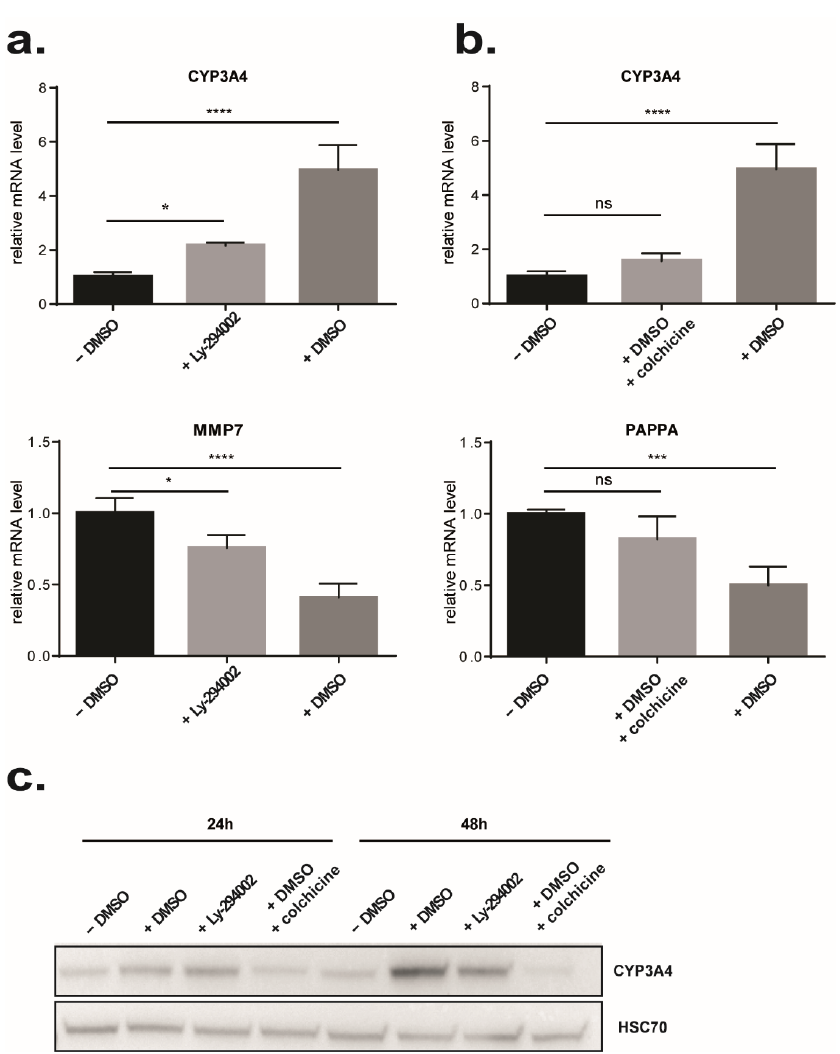
Figure 5. Comparison of DMSO effects with LY294002 and colchicine effects. At day 15 of differen- tiation HepaRG cells were treated for 24 h with 2% DMSO as positive control or with 10 µM LY294002, or 2% DMSO + 10 µM colchicine or let in classical medium without DMSO (negative control). ( a ) Effect of LY294002 treatment on CYP3A4 and MMP7 expressions was confirmed by real-time RT-PCR. (n = 4). ( b ) Effect of colchicine treatment on CYP3A4 and PAPPA expressions was confirmed by real-time RT-PCR. (n = 4). Results are expressed as relative to condition HepaRG D15 (24 h), arbitrary set to 1. * p < 0.05, *** p < 0.001, **** p < 0.0001. ns: not significant. ( c ) Effects of DMSO, Ly294002, and colchicine on the protein level of CYP3A4 were analyzed by Western blot after 24 h and 48 h of